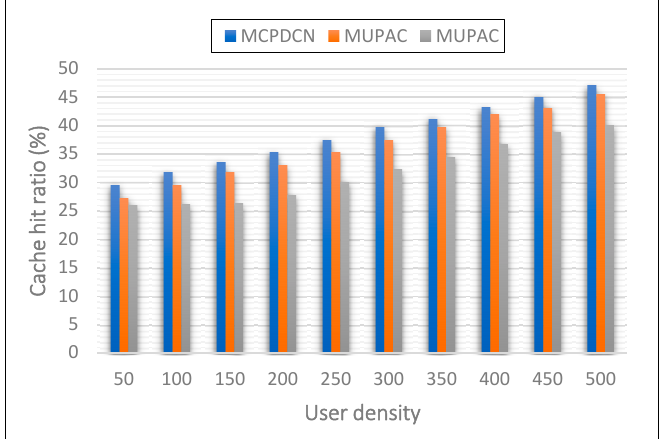
Figure 9. MUPAC vs MCPDCN (cache hit ratio) in terms of user density.